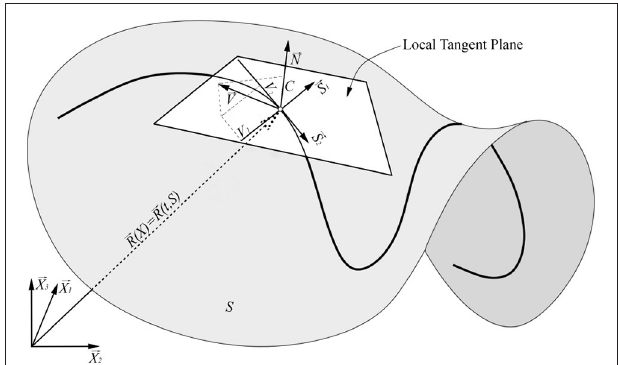
FIGURE 1 | Graphical illustration of the arbitrary surface and its’ local tangent plane. E S 1 , E S 2 , E N are local tangent plane base vectors and local surface normal, respectively. E X 1 , E X 2 , E X 3 are arbitrary base vectors of the ambient Euclidean space and E R = E R ( X ) = E R ( t , S ) is radius vector of the point. E V is arbitrary surface velocity and C , V 1 , V 2 display projection of the velocity to the E N , E S 1 , E S 2 directions,